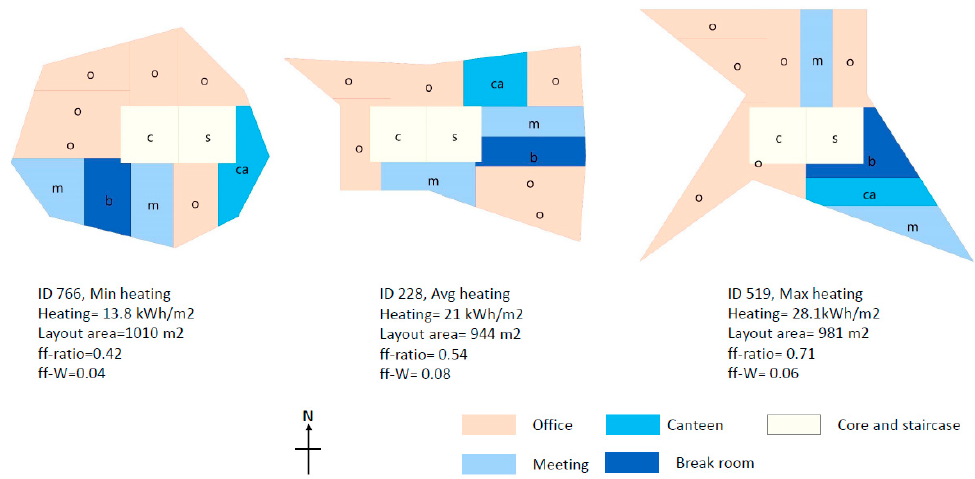
Figure 8. The layout with minimum heating demand, average heating demand and maximum heat ‐ ing demand, resulting from the optimisation for minimising heating demand.